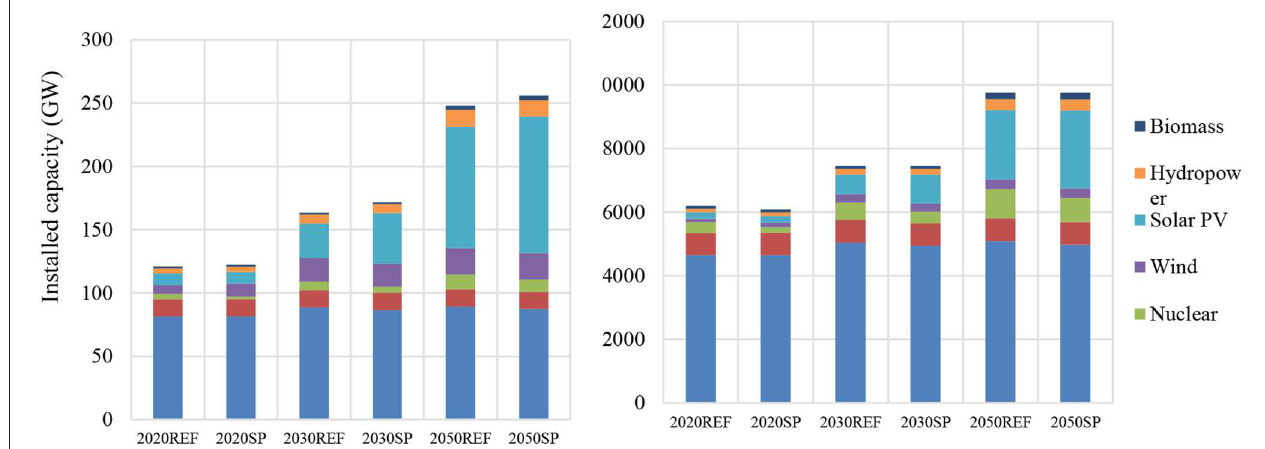
FIGURE 4 | Installed capacity and power generation in SP and REF scenarios.